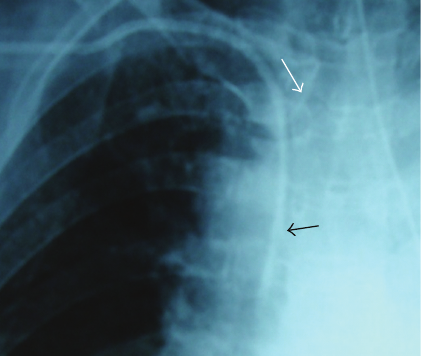
Figure 1: Chest X-ray showing the “sheared” (black arrow) central venous catheter and the “tracheal bronchus” (white